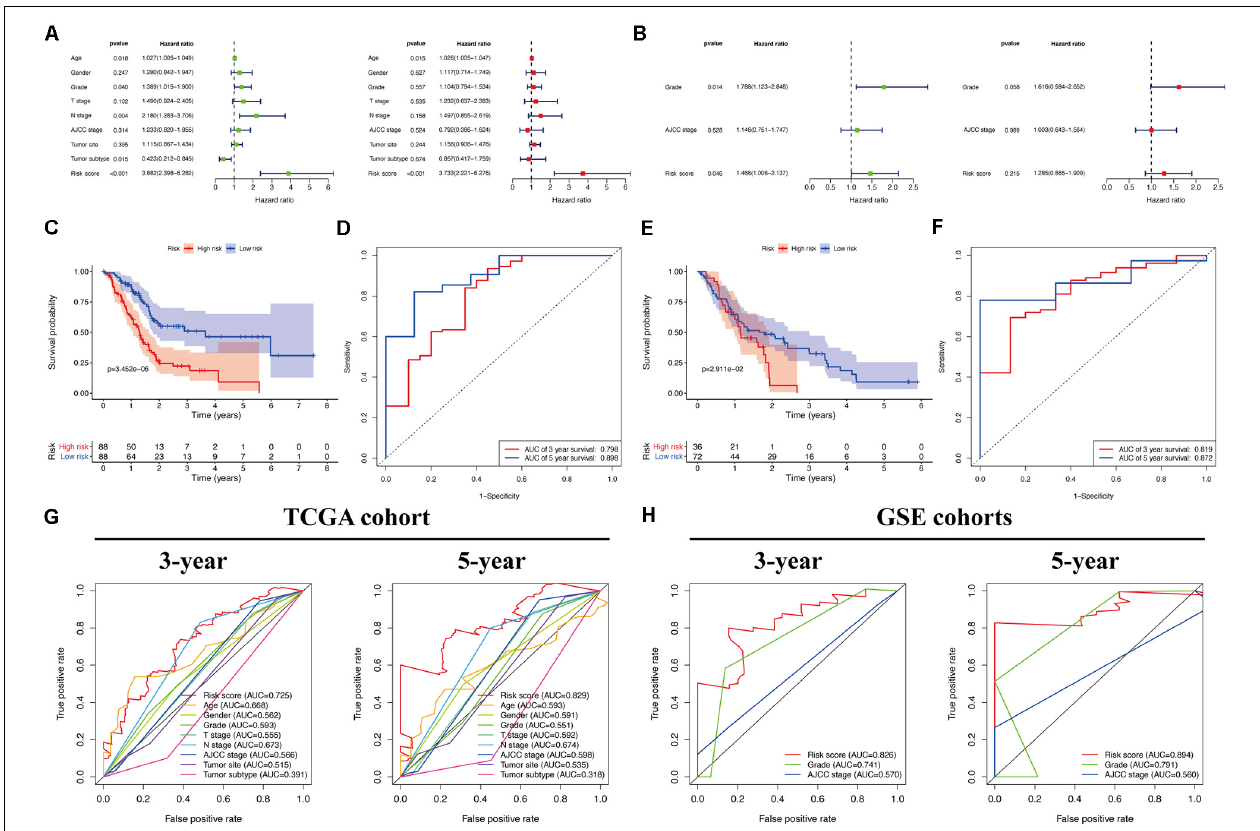
FIGURE 7 | Efficacy evaluation of constructed prognostic model. Univariate and multivariate Cox regression analysis of the clinicopathological features in TCGA (A) and validation (B) cohorts. (C) Survival curve of TCGA cohort. (D) TimeROC curves for forecasting overall survival in TCGA cohort. (E) Survival curve of validation cohort. (F) TimeROC curves for forecasting overall survival in validation cohort. ClinicalROC curves for forecasting overall survival in TCGA (G) and validation (H)